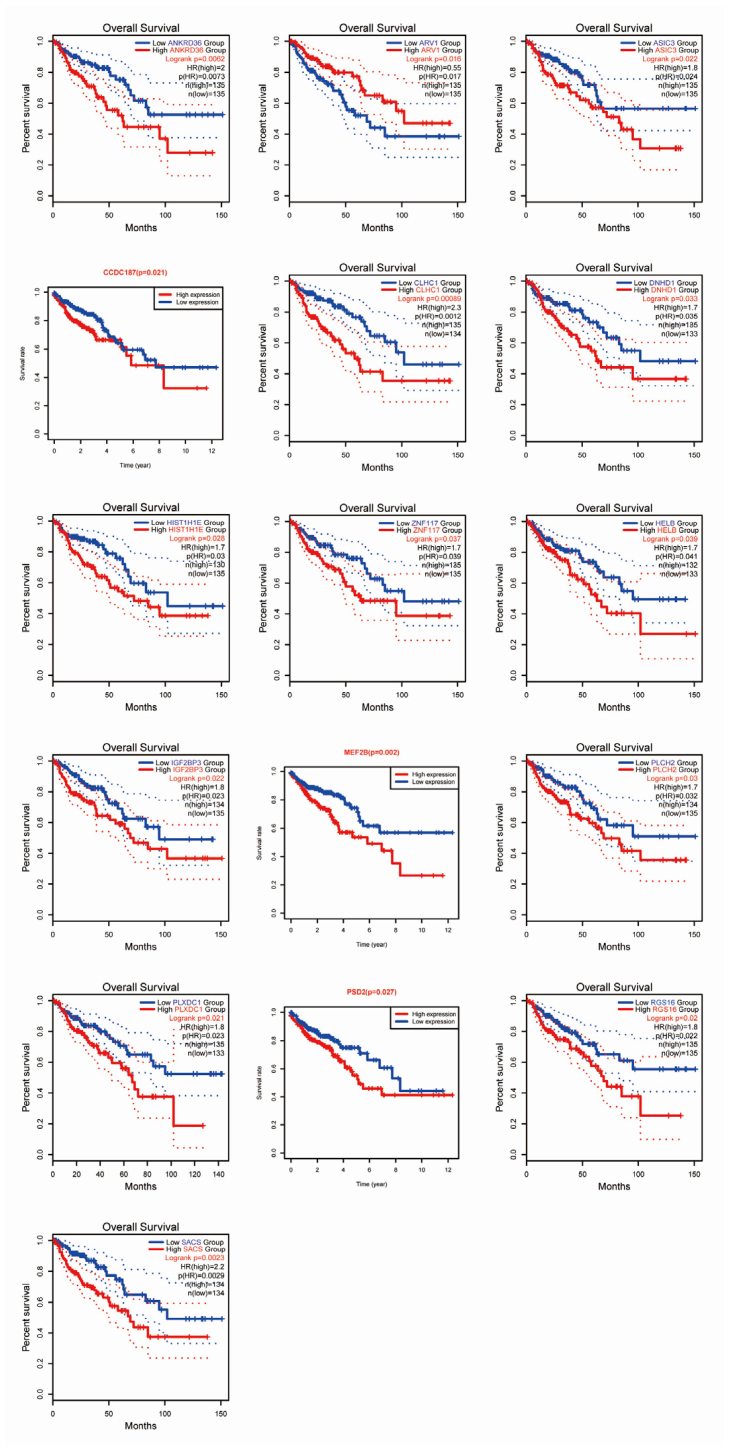
Figure 5. Correlation analysis of 16 DEGs with COAD